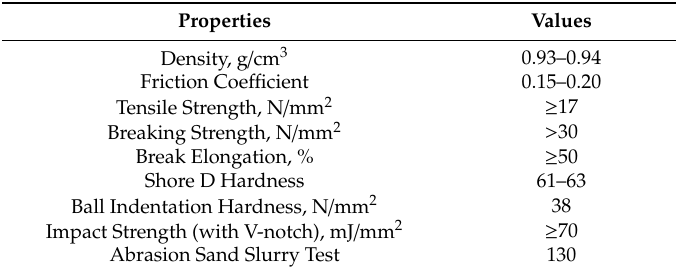
Table 6. Properties of the material used by the “Shibata Fender Team AG